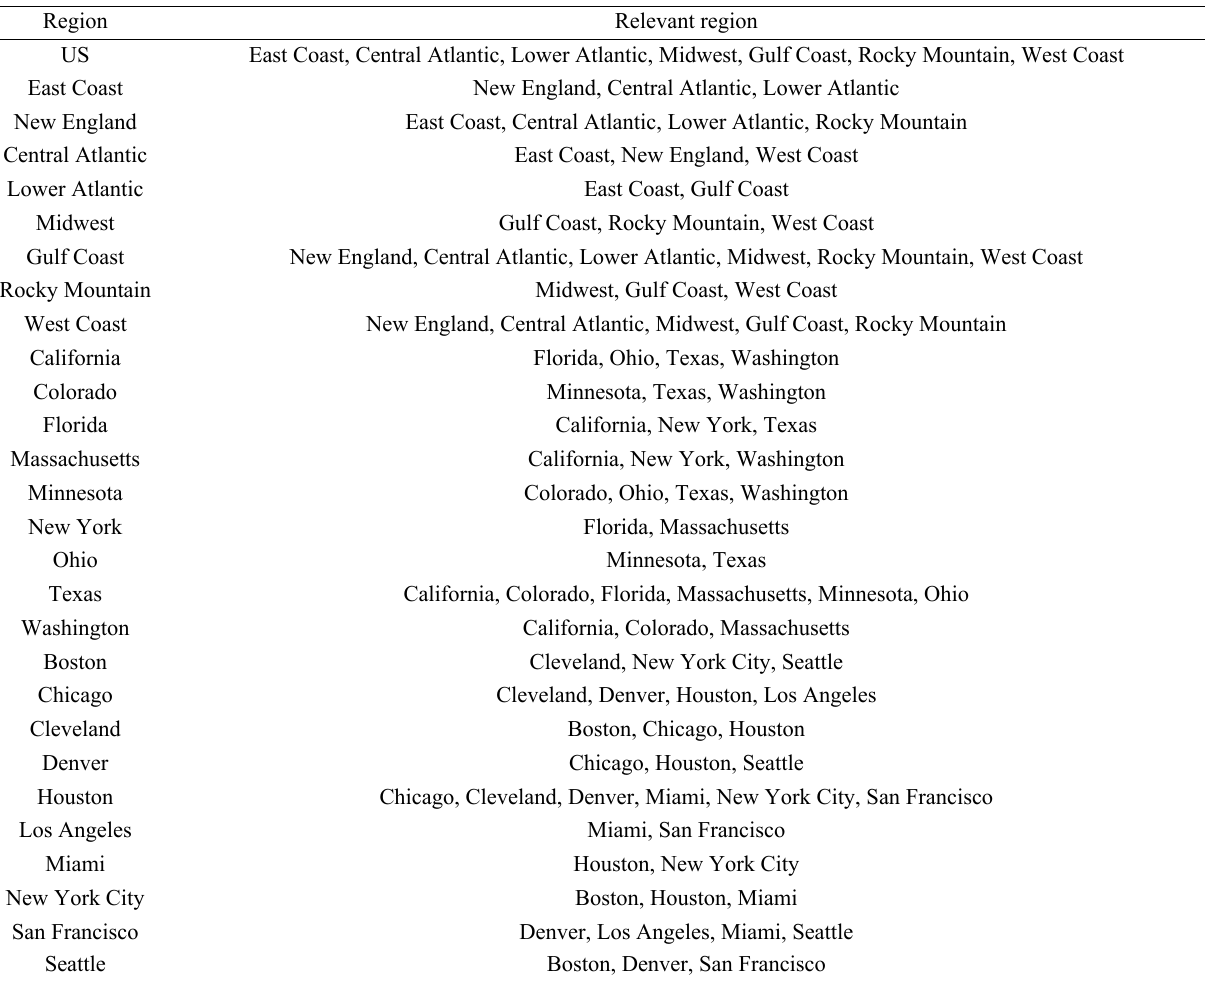
Table 1 Linkage of regional gasoline prices. Relevant region